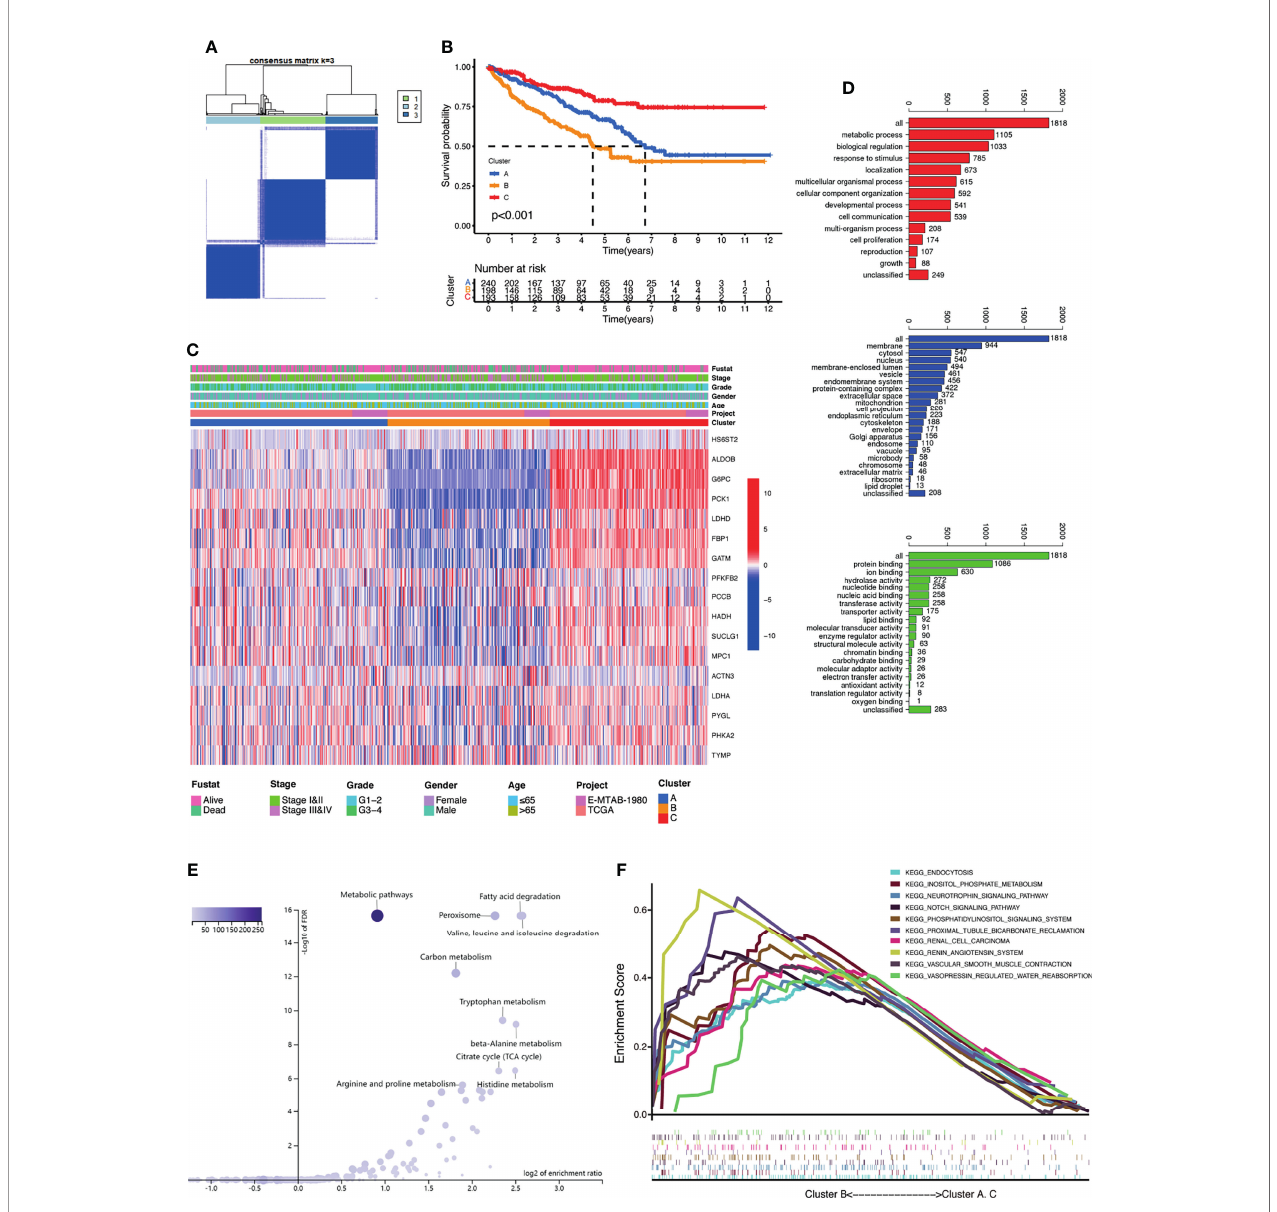
FIGURE 2 | Clusters of differentially expressed lactate-related genes (LRGs) and biological characteristics in kidney renal clear cell carcinoma (KIRC). (A) Unsupervised clustering of the 17 differentially expressed LRGs and optimal consensus matrices for k = 3. (B) Survival analysis of three LRG clusters. (C) Unsupervised clustering of the 17 differentially expressed LRGs in the two KIRC cohorts (TCGA and E-MTAB-1980). (D) Gene Ontology (GO) annotation of 1,818 lactate phenotype-related differentially expressed genes (DEGs). (E) Kyoto Encyclopedia of Genes and Genomes (KEGG) pathway analysis of the above-mentioned genes. (F) Gene set enrichment analysis (GSEA) of several cancer-related pathways enriched in cluster